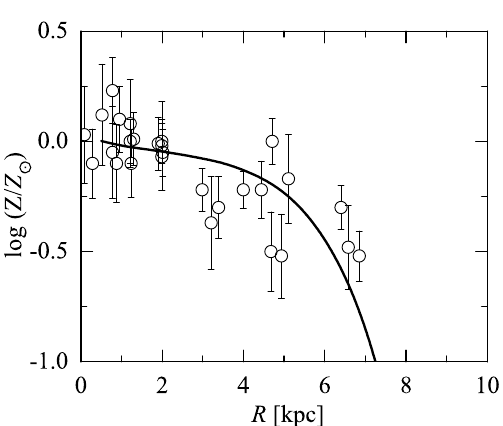
Fig. 6. The metallicity profile of gas in M 33. The solid line denotes the average of 30 models; the circles with error bars indicate the abundances in blue supergiants from Urbaneja et al. (2005) and U et al.